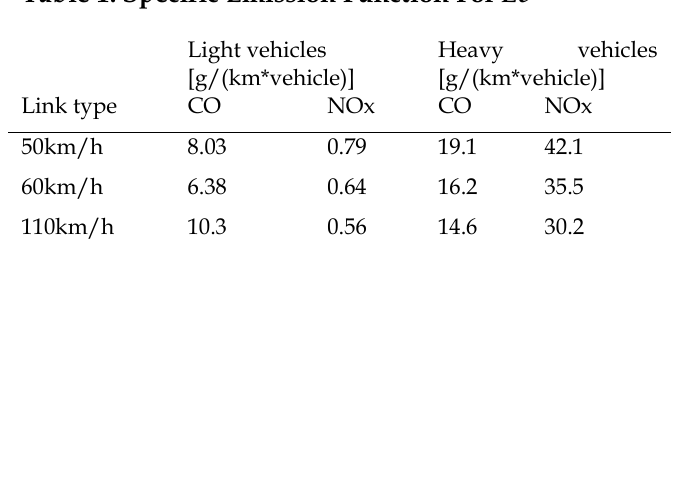
Table 1. Specific Emission Function For